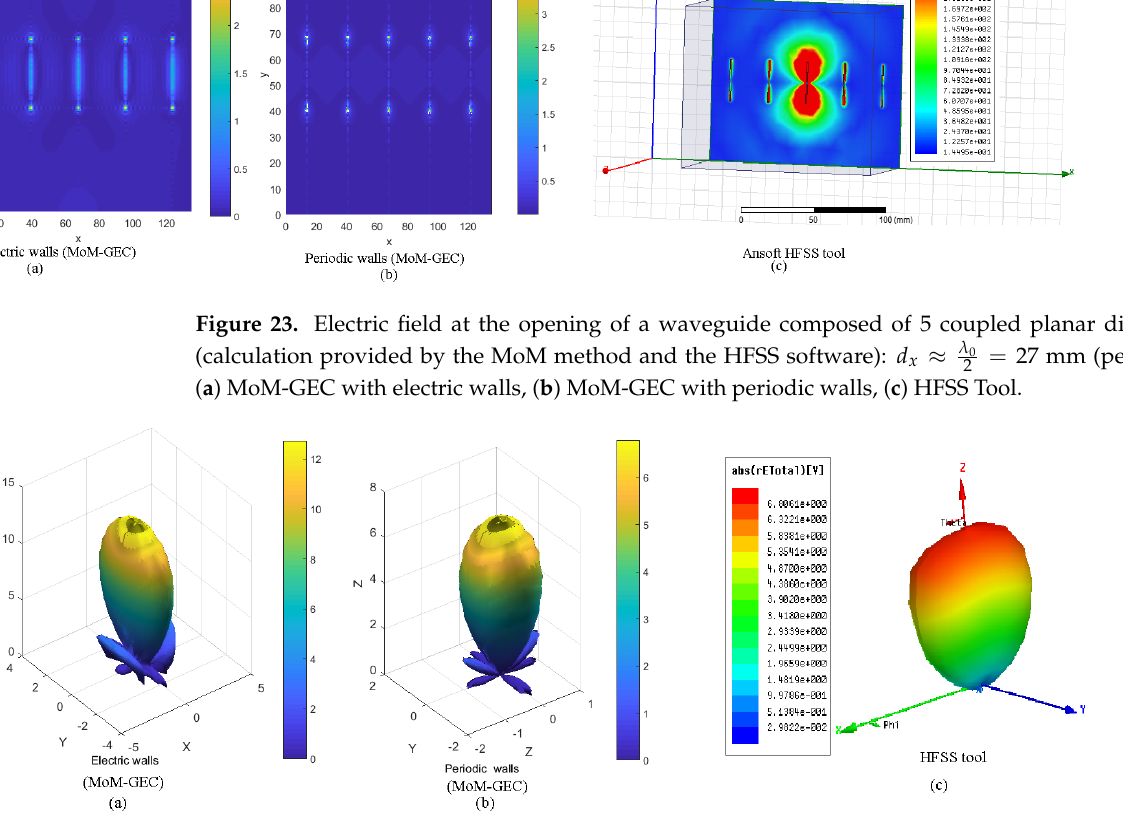
Figure 24. 3D radiation patterns proven with the MoM-GEC method (with electric and periodic walls) compared to the HFSS software for a coupled periodic antenna array with 5 elements and = 27 mm (period): ( a ) MoM-GEC with electric walls, ( b ) MoM-GEC with periodic walls, d x ≈ λ 0 2 ( c ) HFSS Tool.